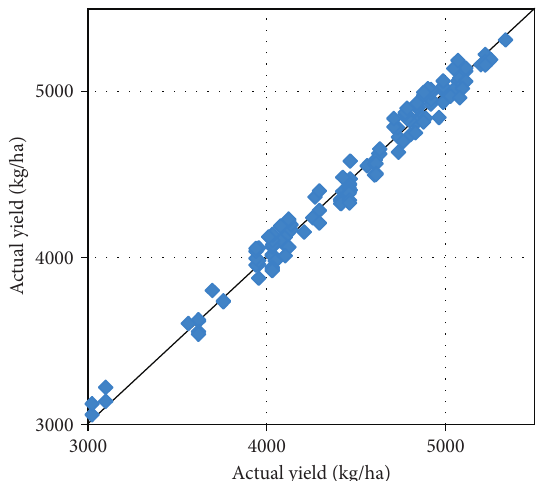
Figure 6: Distribution of error of the predicted yield.